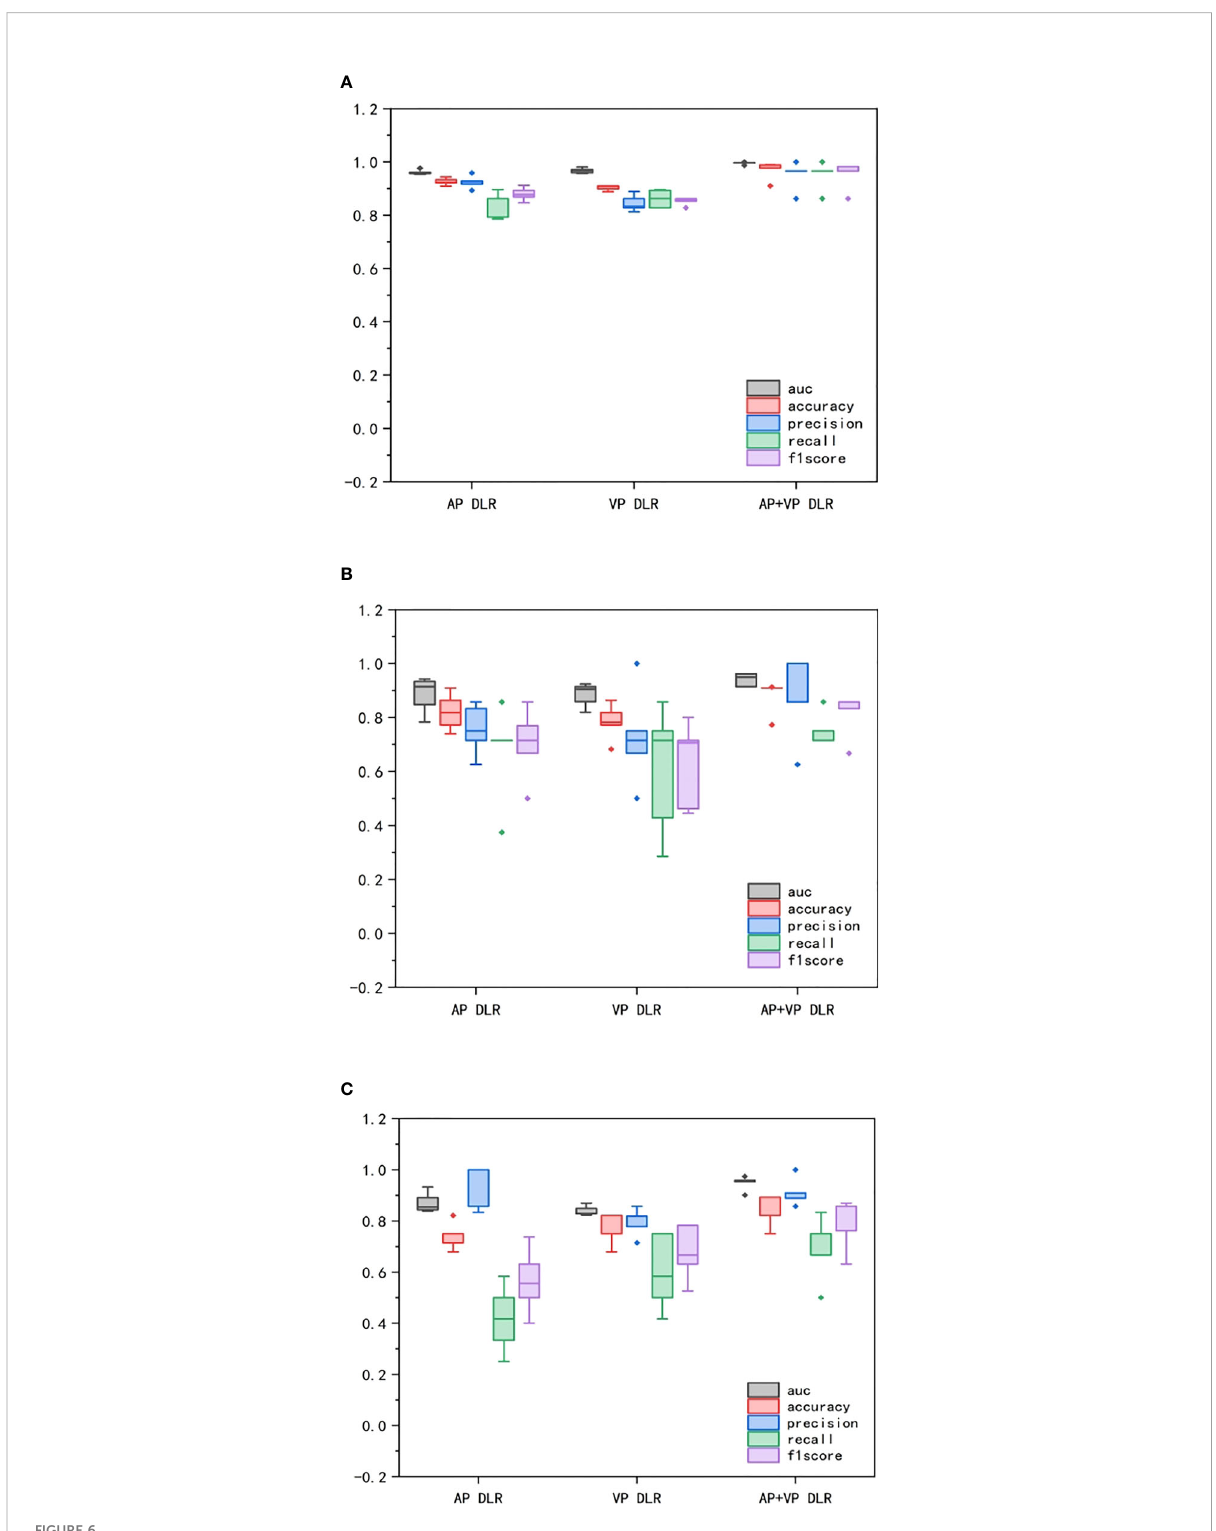
FIGURE 6 Comparison of performance among CNN models in different groups. (A) represented training group. (B) represented validation group. (C) represented test group. The box-and-whisker plots demonstrated the differences in AP, VP, AP+VP models among AUC, accuracy, precision, recall, and F1